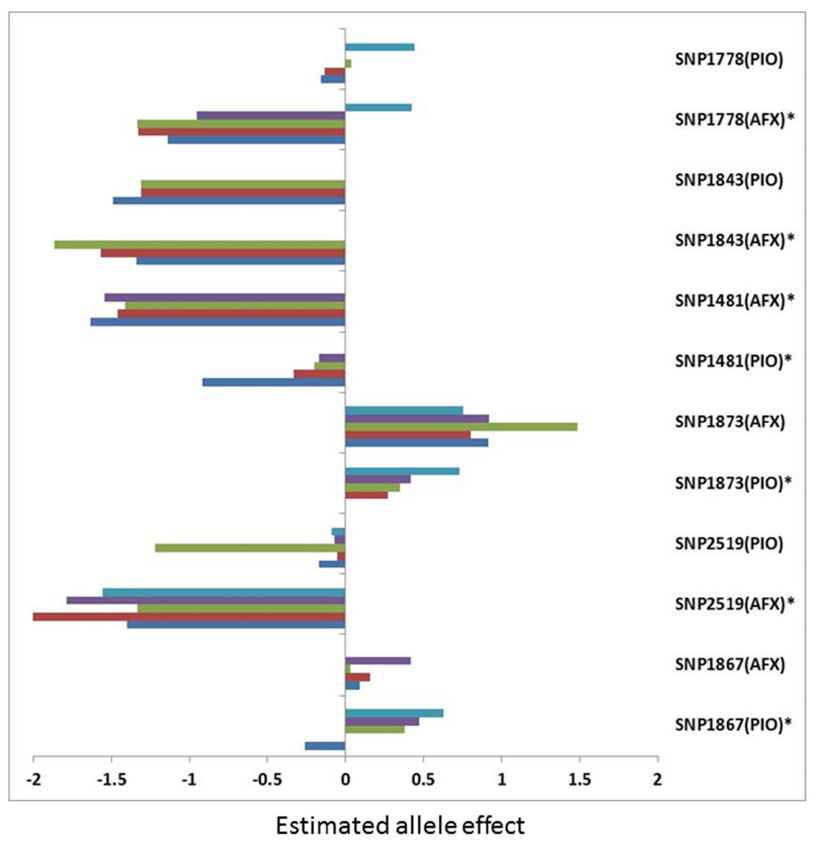
Fig. 5. Comparison of allele effects of six significant SNP markers associated with Verticillium wilt resistance between the pioneer and Alforex populations. Estimated values were represented by bars and different allele types (up to 5 alleles per locus) were distinguished by different colors. Star ‘‘*’’ indicates the population in which the significant marker was